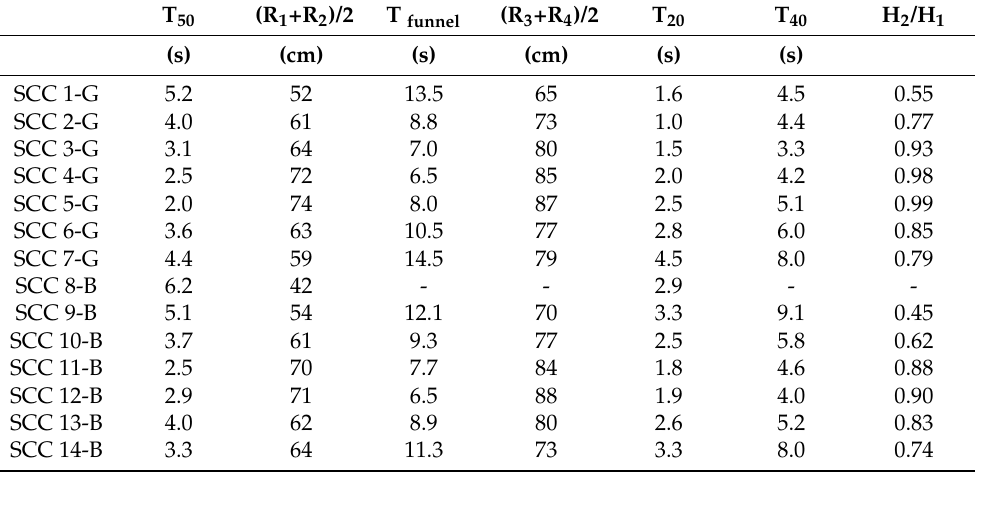
Table 15. Juxtaposition of the results of the analyses of the rheological features of concrete mixes.